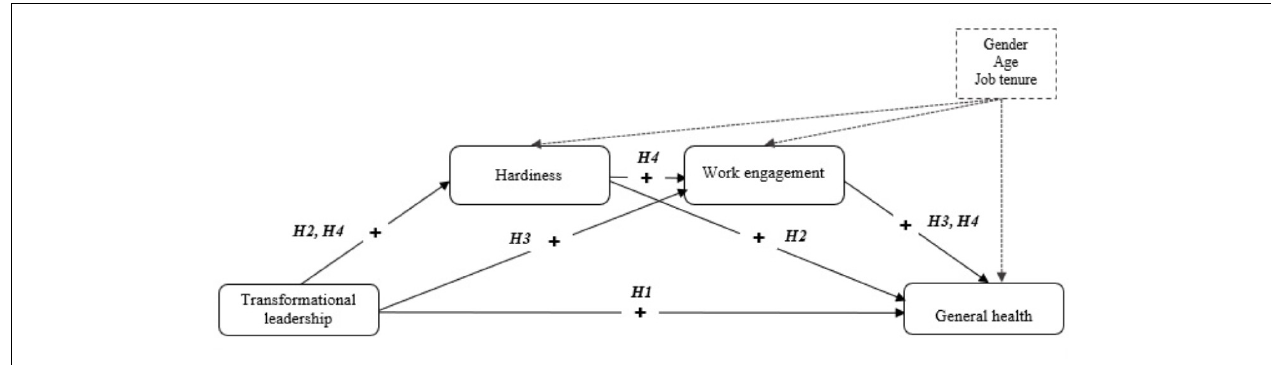
FIGURE 1 | The hypothesized serial mediation